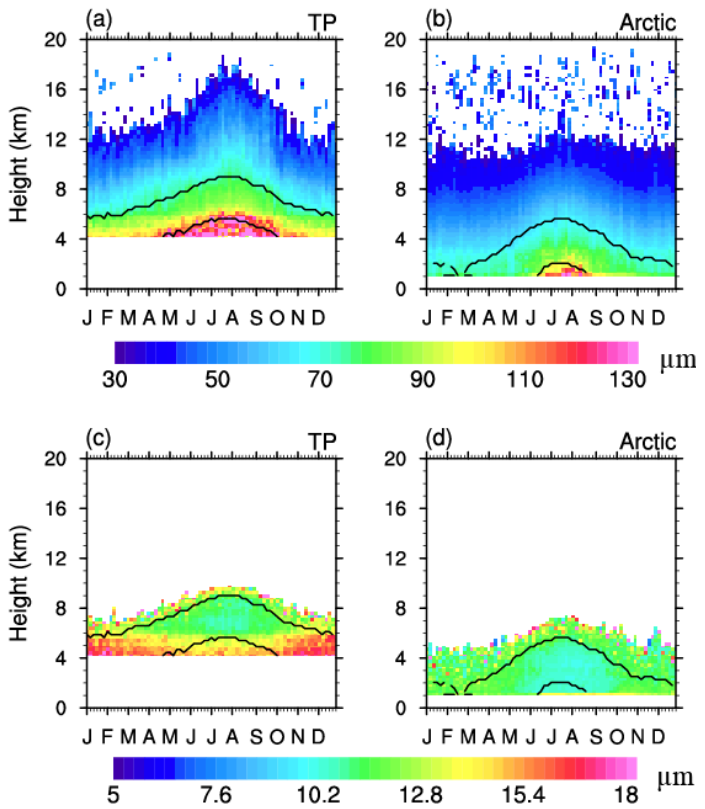
Figure 2. Seasonal cycle of the vertical distribution of the cloud ice ( upper panels ), ( a , b ) and liquid ( lower panels ), ( c , d ) particle effective radius over the TP ( left panels ), ( a , c ) and the Arctic ( right panels ), ( b , d ). The upper and lower black lines in each plot represent the climatic locations of − 20 and 0 ◦ C that are calculated from the ECMWF–aux (version r04)